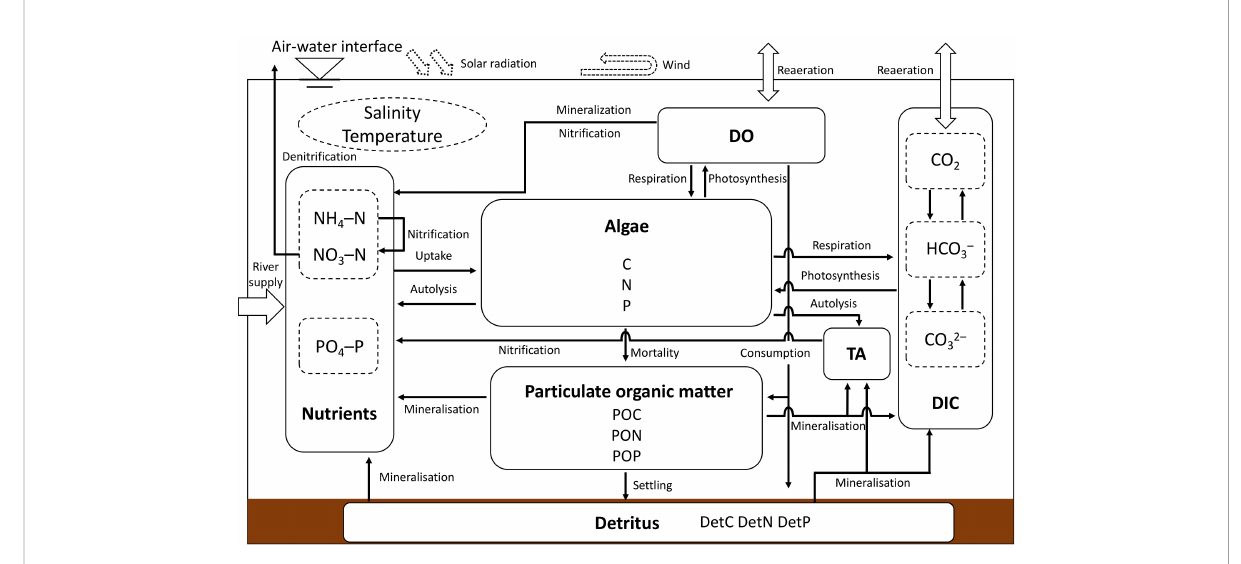
FIGURE 3 Structural diagram of the ecological model (modi fi ed from the generic ecological model developed by Blauw et al. (Blauw et al.,